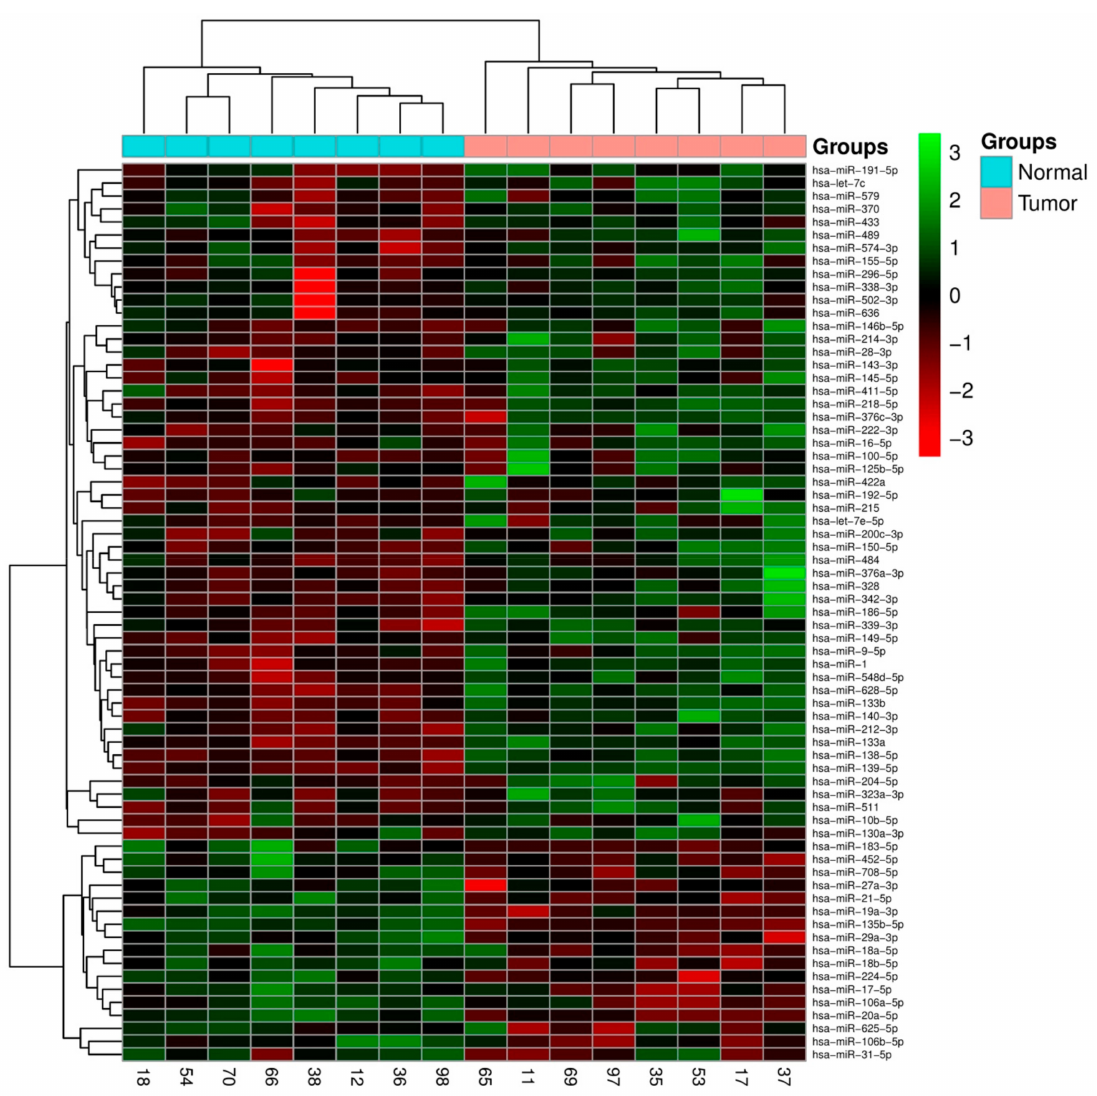
Figure 1. A 67-miRNA expression signature reveals changes between colorectal cancer (CRC) and NCT. Unsupervised hierarchical clustering analysis of CRC (blue) and NCT (pink) was performed using 67 di ff erentially expressed miRNAs. Dendrograms of clustering analysis for samples and miRNAs are displayed on the top and left, respectively, and depict similarities in the miRNA expression profiles among the samples. The relative up and down regulation of miRNAs is indicated by red and light green, respectively. hsa; Homo sapiens . Endogenous control assays are present (MammU6, RUN44, and